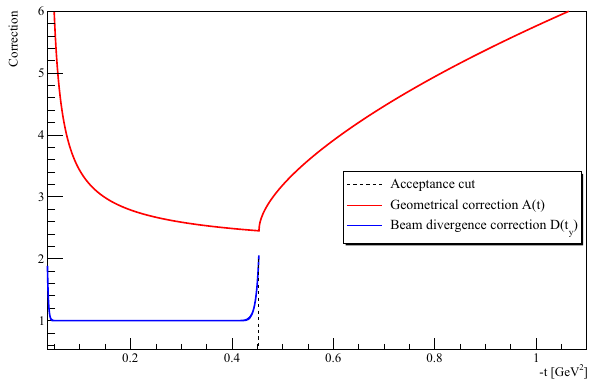
Fig. 5 The geometrical acceptance correction A ( t ) is defined by the cuts of Fig. 4. The beam divergence correction D ( t y ) depends on the vertical collinearity cut θ ∗ y shown in Fig 2: the angular window and the σ of the cut determines the missing acceptance in the corners. Note that the data extends up to 4.0 GeV 2 due to the horizontal acceptance, see also Fig. 2